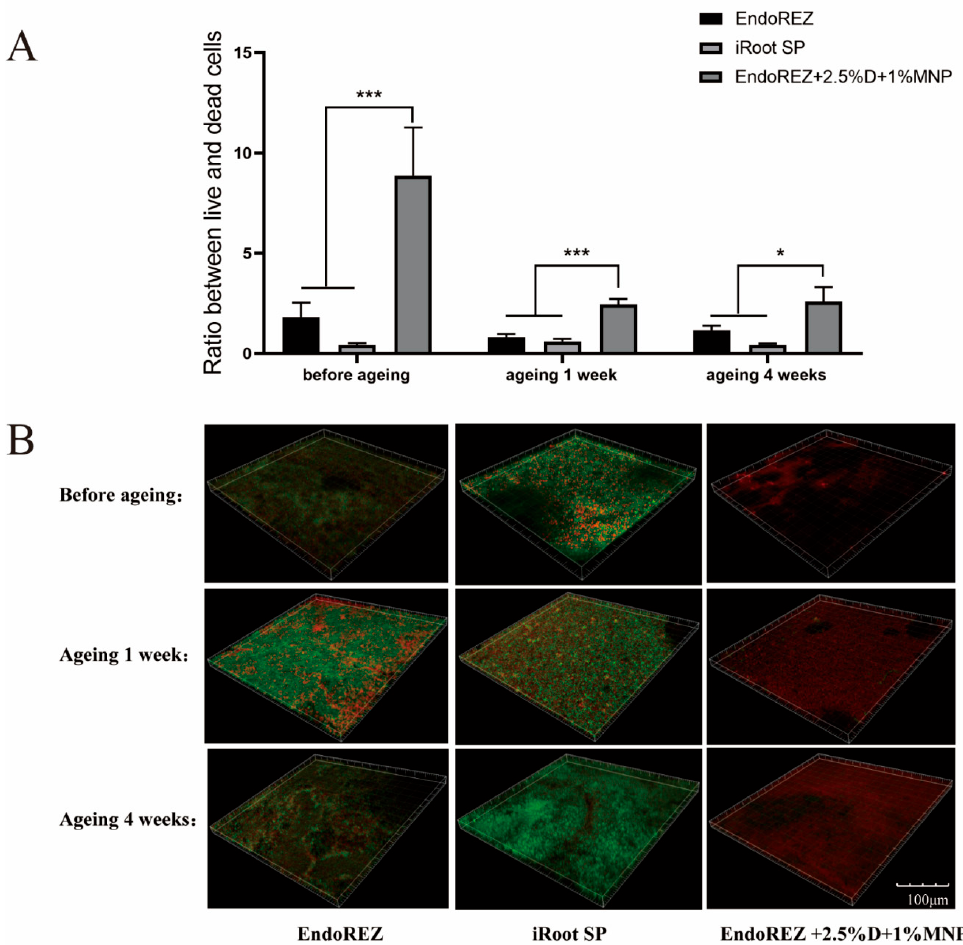
Figure 4. Live/dead bacteria staining. ( A ) The ratio of the live bacteria cells to dead cells was computed in line with 3 random sights of biofilms. ( B ) Representative images of biofilms (live bacteria—stained green; dead cells—stained red) in different groups. Every value is shown as mean ± SD; * p < 0.05, *** p < 0.001.